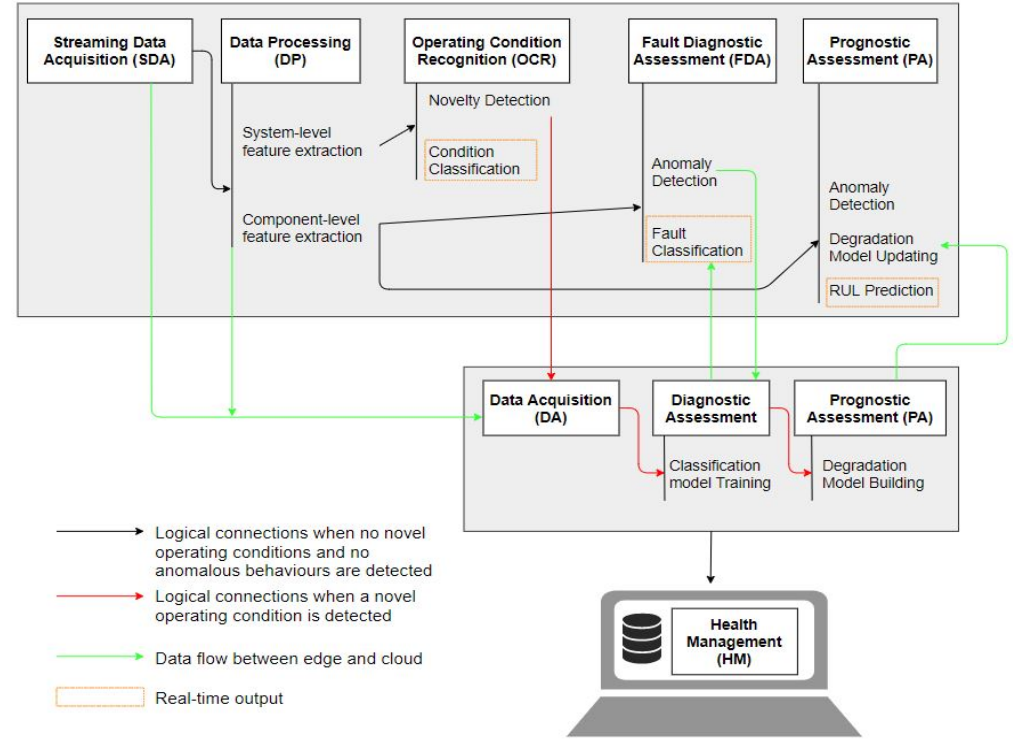
Figure 5. The proposed logical architecture.